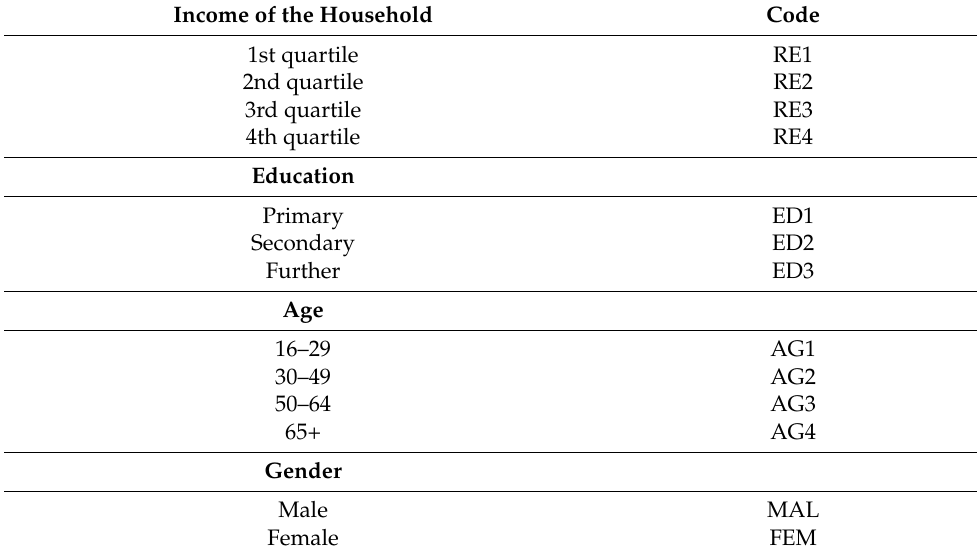
Table 3. Sociodemographic groups—survey subcategories.